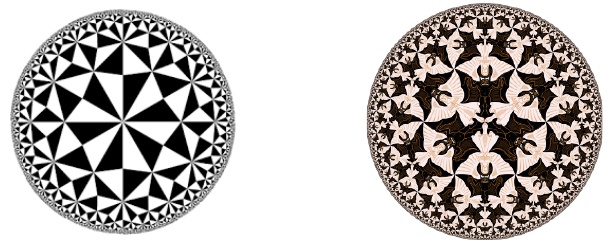
Figure 2 . Left: Escher’s tessellation of the (cid:13)at surface plane with Angels and Devils design. Right: Escher’s tessellations of the (cid:13)at surface plane with Lizard/Fish/Bat design.